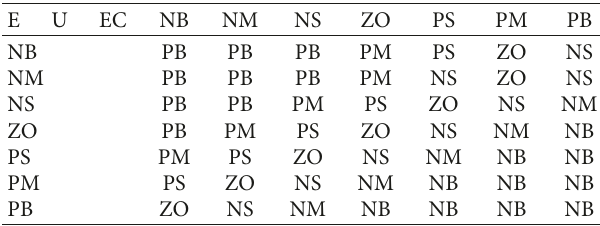
Table 2: Fuzzy control rule